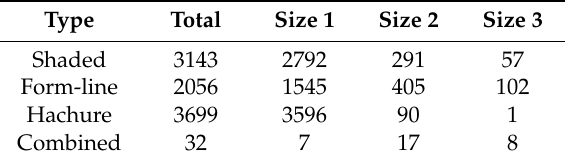
Table 2. The mound feature type and size categories of features recorded on the georeferenced maps.